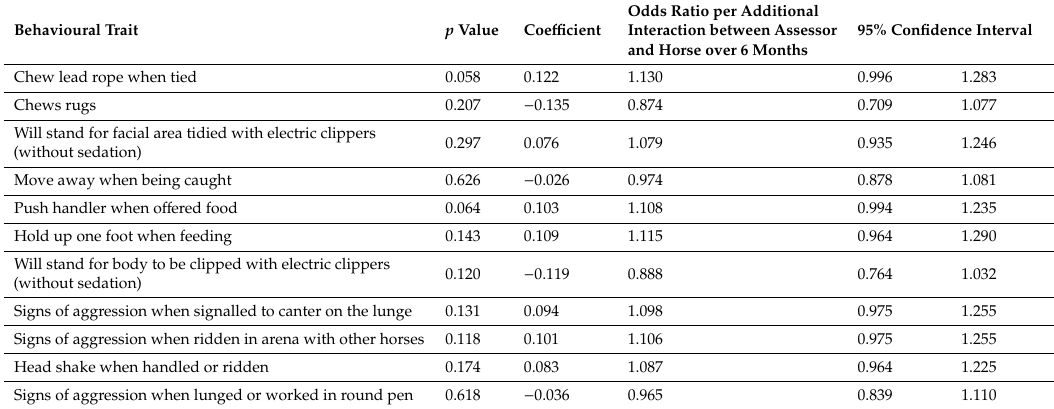
Table 5. Interactions between assessor and horse for 11 behavioural traits with at least 5% mean di ff erence scores between mares and geldings and univariate p <